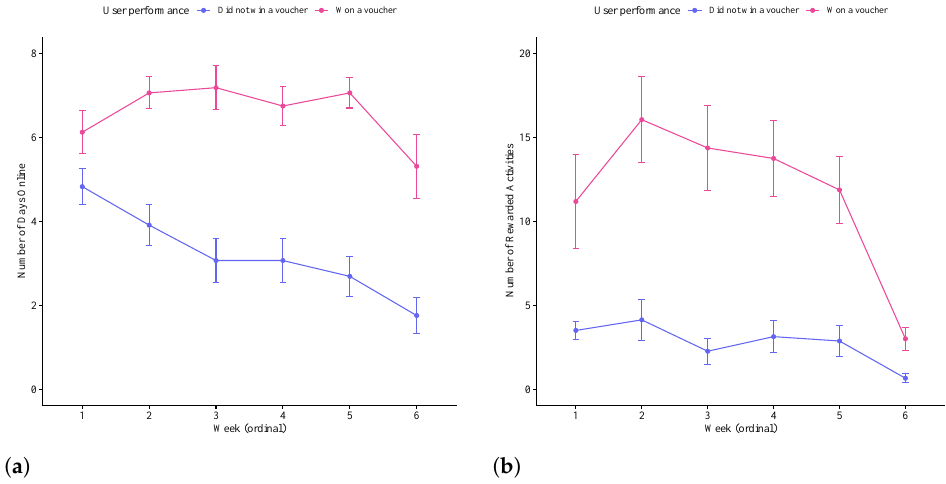
Figure 6. Mean plots per participants that either did, or did not win a voucher of: ( a ) the number of days participants visited the web app (all participants, N = 61), and ( b ) the number of activities participants registered (active participants, N =